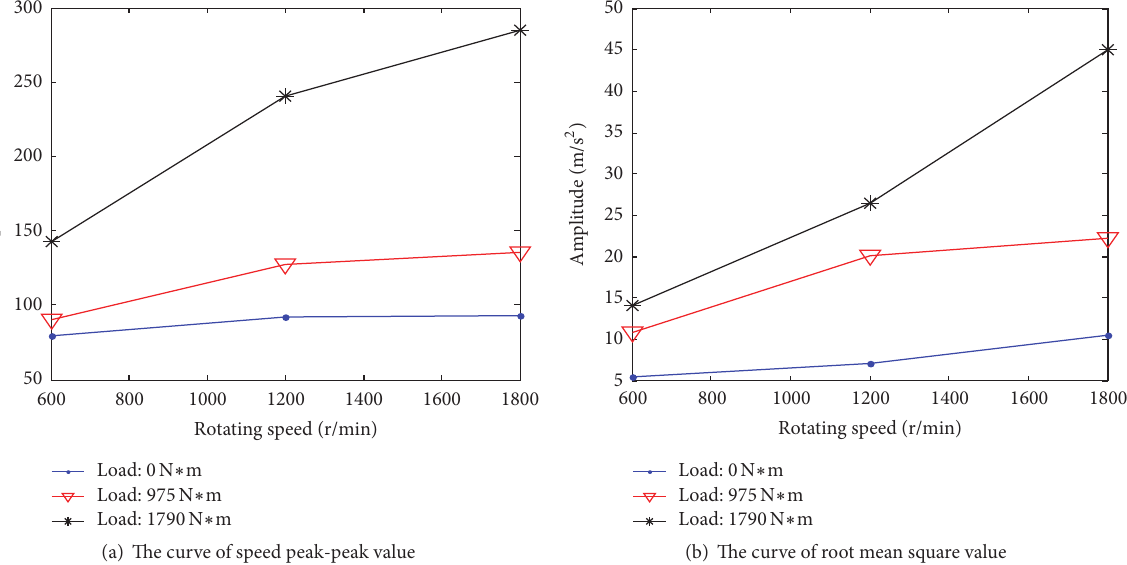
Figure 3: Broken teeth-pitting compound fault 1.